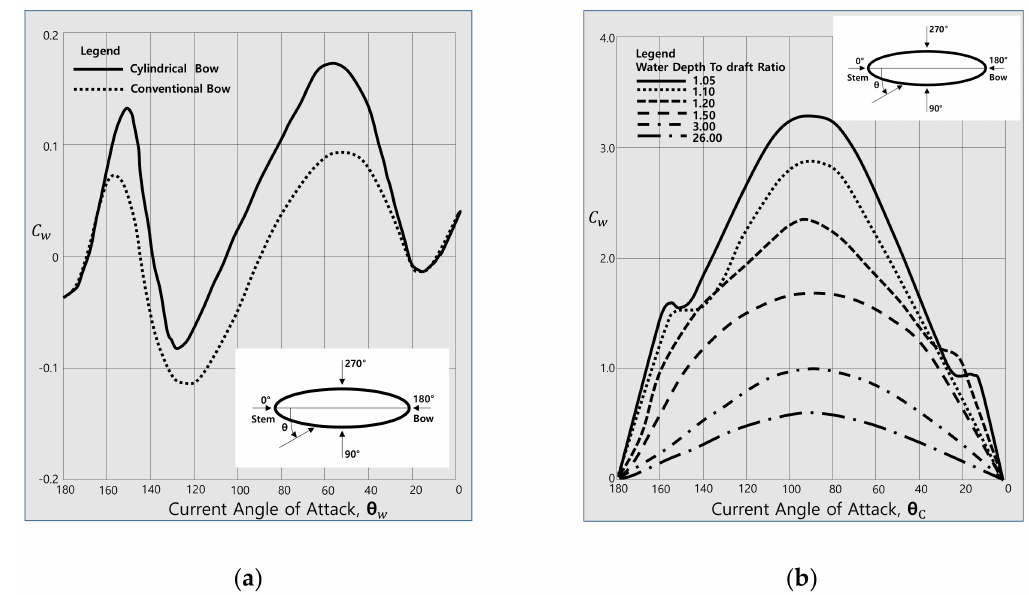
Figure 5. ( a ) Longitudinal current drag force coe ffi cient—loaded tanker (WD / T = 1.1); ( b ) lateral current drag force coe ffi cient—loaded tanker.